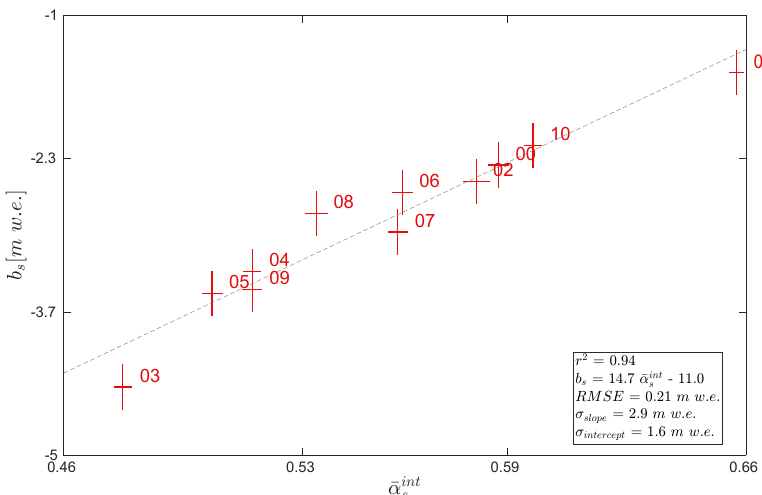
Figure 7. Summer SMB b s expressed as a function of the integrated albedo over the entire ablation season for Saint-Sorlin Glacier. Error bars result from the uncertainties related to the glaciological method (measurements and interpolation at the glacier scale of the punctual measurements, ± 0.20mw . e . in total), and on the quadratic sum of the systematic errors made on each albedo measurement. The thin dashed grey line represents the linear regression showing the best correlation between the two variables, together with correlation